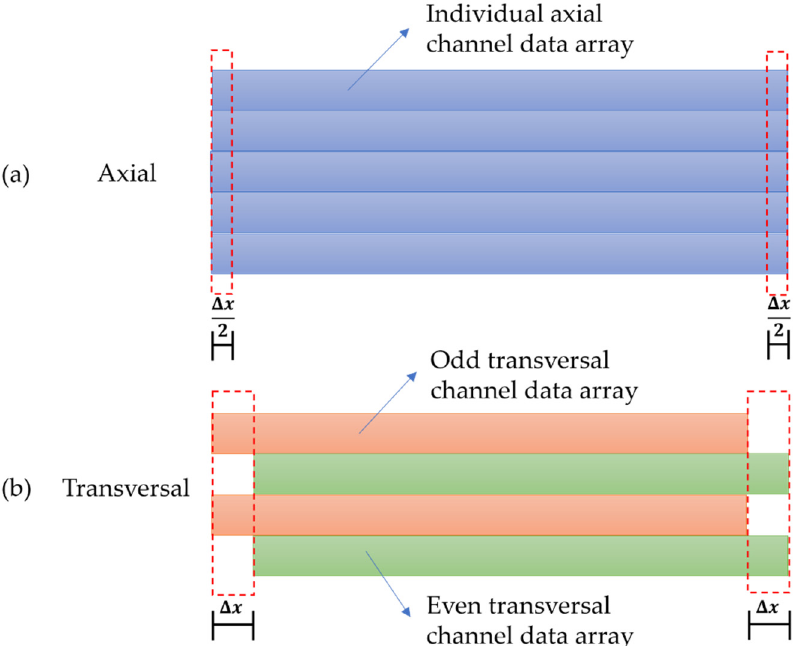
Figure 4. Illustration of complex impedance data positional compensation performed between axial and transversal configurations. ( a ) Axial complex array positional compensation. ( b ) Transversal complex array positional compensation.